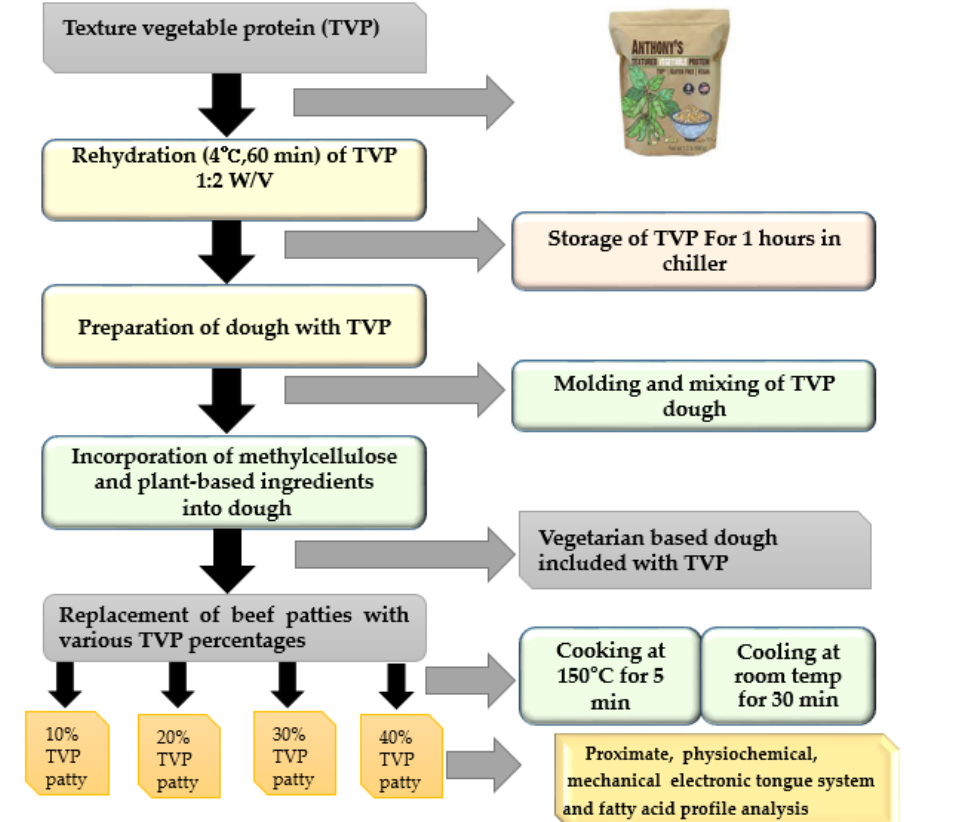
Figure 1. Flow diagram for the manufacture of beef patties with different levels of TVP substituted.